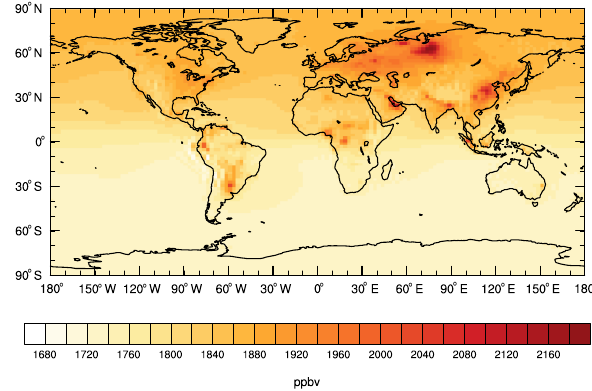
4 Simulated methane in ModelE2-YIBs